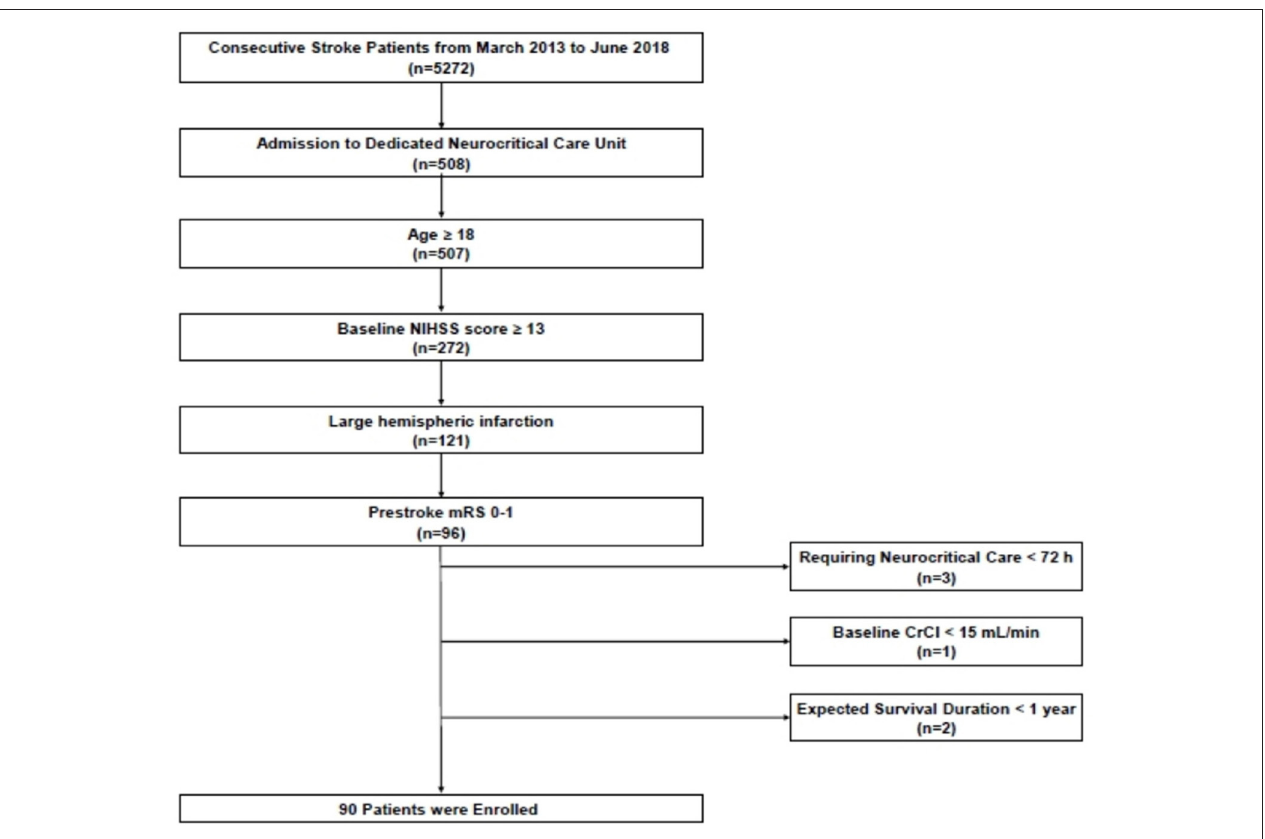
FIGURE 1 | Flowchart of patient screening and enrollment. NIHSS, National Institutes of Health Stroke